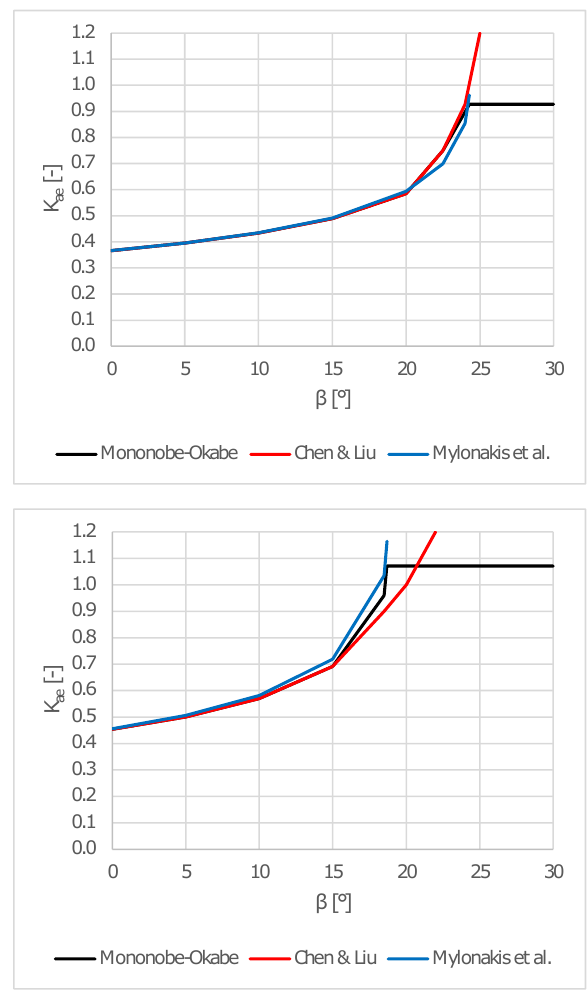
Figure 5. Comparative calculations of the effect of cohesion on active seismic earth pressure coefficient: k h = 0 . 1 (top) and k h = 0 . 2